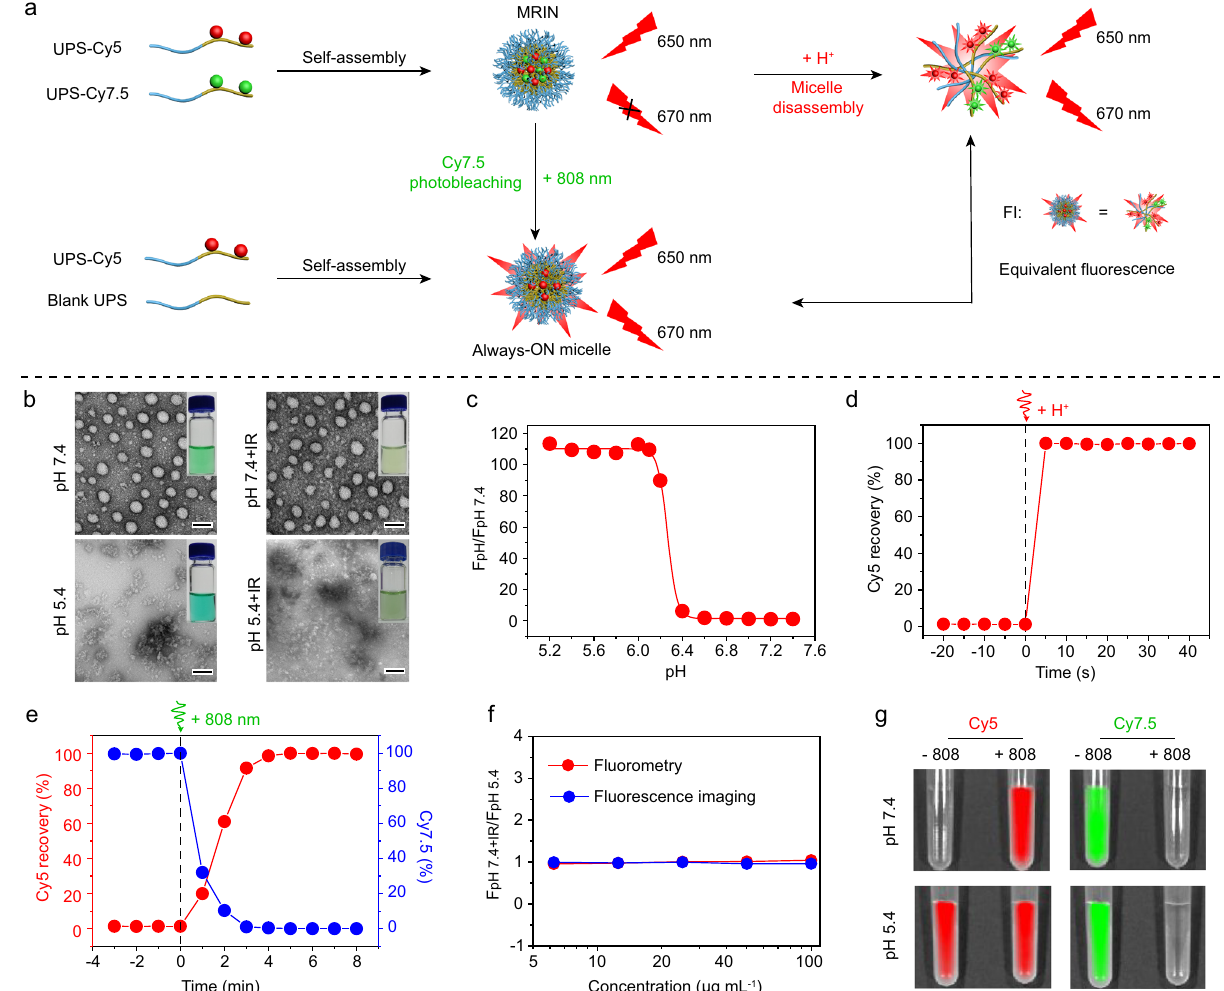
Fig. 2 pH and light sensitivity of MRIN. a Schematic illustration of pH- and light-triggered Cy5 fl uorescence recovery mechanisms. b The photographic and TEM images of MRIN at pH 7.4 and pH 5.4 with or without 808 nm irradiation. Scale bar = 50 nm. c Cy5 fl uorescence ratios as a function of pH values for MRIN at 37 °C. d pH-triggered Cy5 fl uorescence recovery versus time pro fi le upon hydrochloric acid (HCl) addition. e Light-triggered Cy5 fl uorescence recovery and Cy7.5 photobleaching of MRIN. The percentage of Cy5 fl uorescence recovery and Cy7.5 fl uorescence decay versus time pro fi le upon 808 nm irradiation (0.5 W cm − 2 ). f The comparison of Cy5 fl uorescence recovery by pH-induced micelles dissociation and light-induced Cy7.5 photobleaching. The Cy5 fl uorescence signals were recorded using fl uorescence spectrophotometer or IVIS in vivo imaging system. g Fluorescence images of MRIN in pH 7.4 and pH 5.4 PBS buffers with or without 808 nm